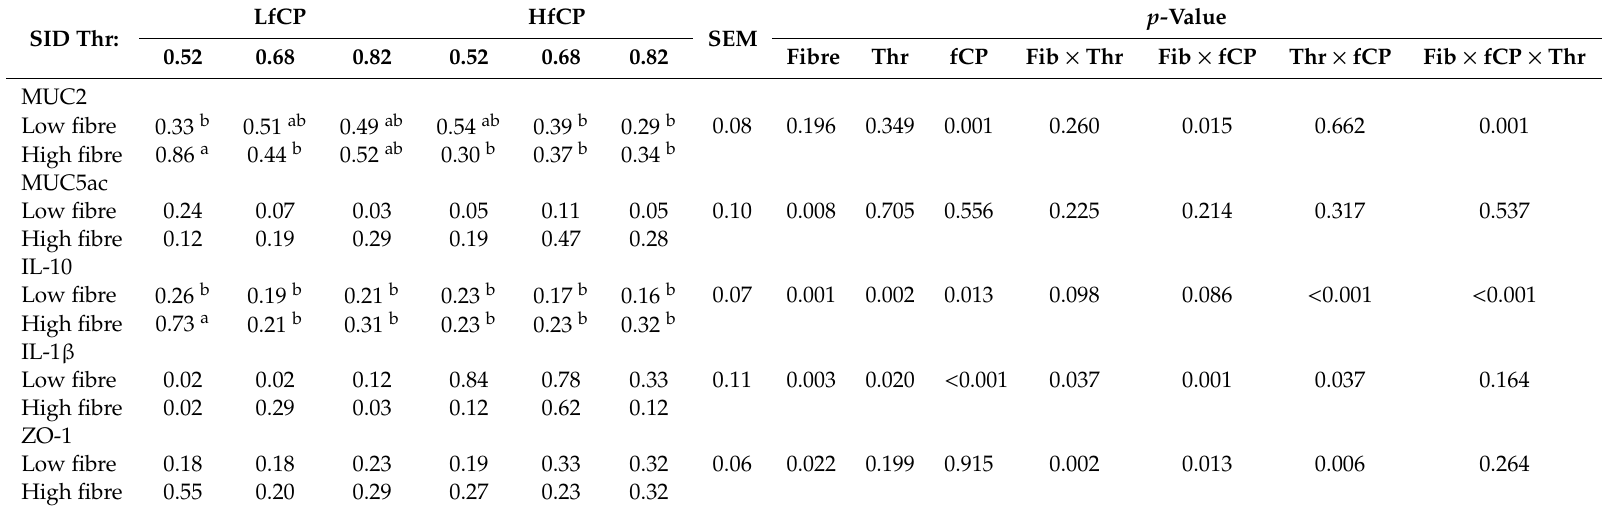
Table 6. Colonic tissue mRNA abundance (arbitrary units) of markers of intestinal health in pigs 1